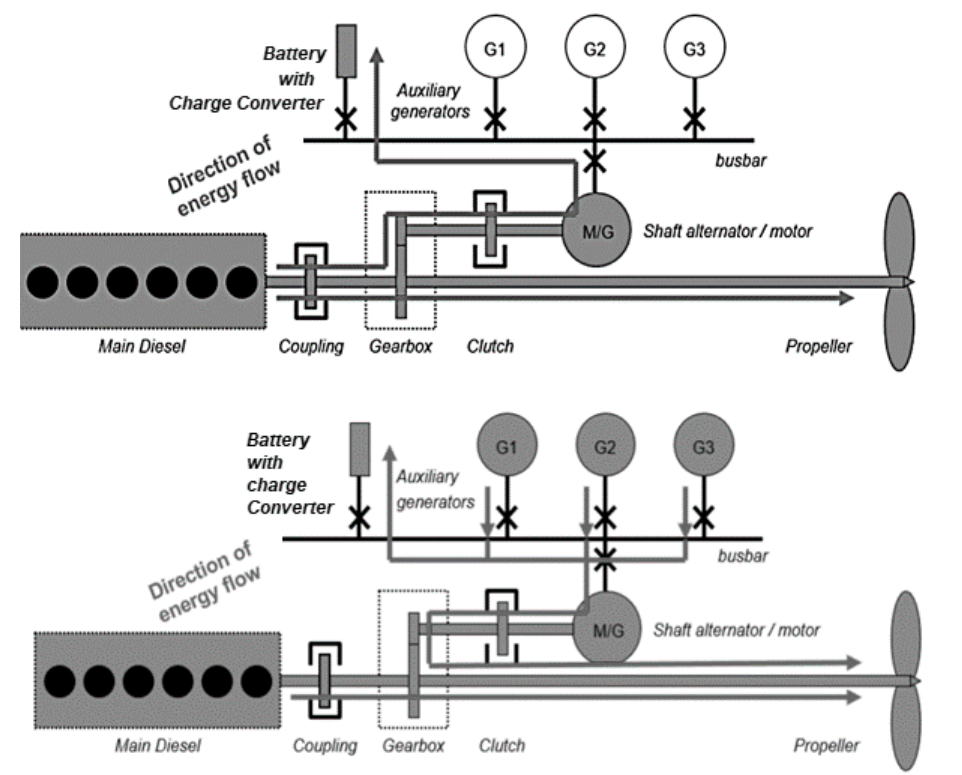
Figure 1. Hybrid battery–diesel propulsion configuration showing PTO (Power Take Out) mode of operation ( top ) and PTI (Power Take In) mode of operation ( bottom ).